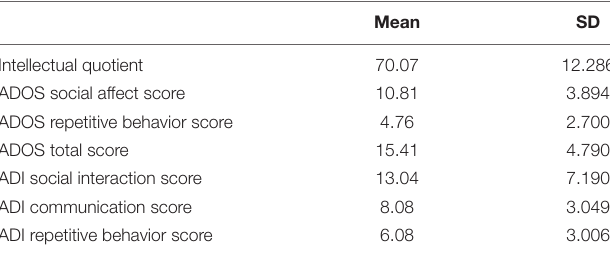
TABLE 1 | Neuropsychological variables of the sample enrolled (34